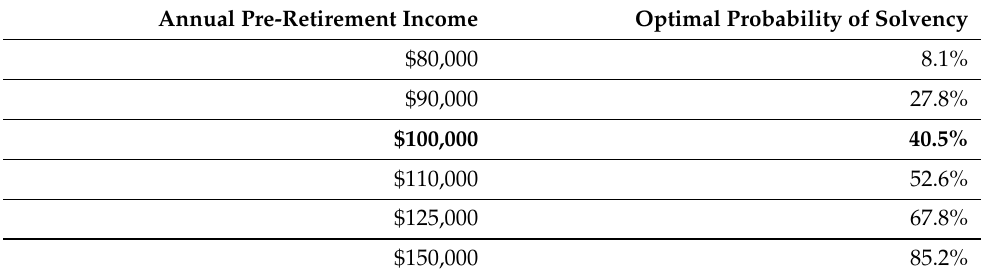
Table 12. The effect on Investor #2 of varying the pre-retirement income, in t = 0 pre-tax dollars, from its normal value (in bold).